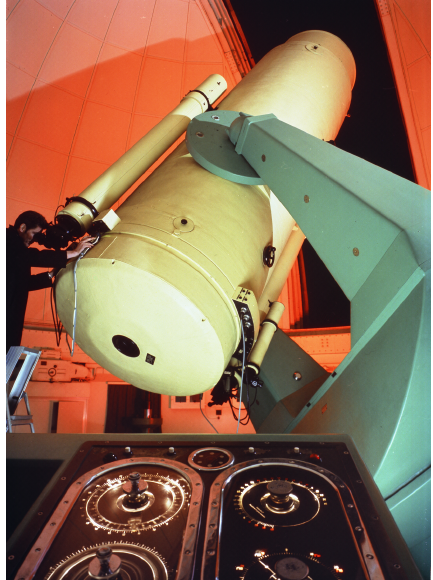
Fig. 1. Large Hamburg Schmidt with Uli Haug observing, around